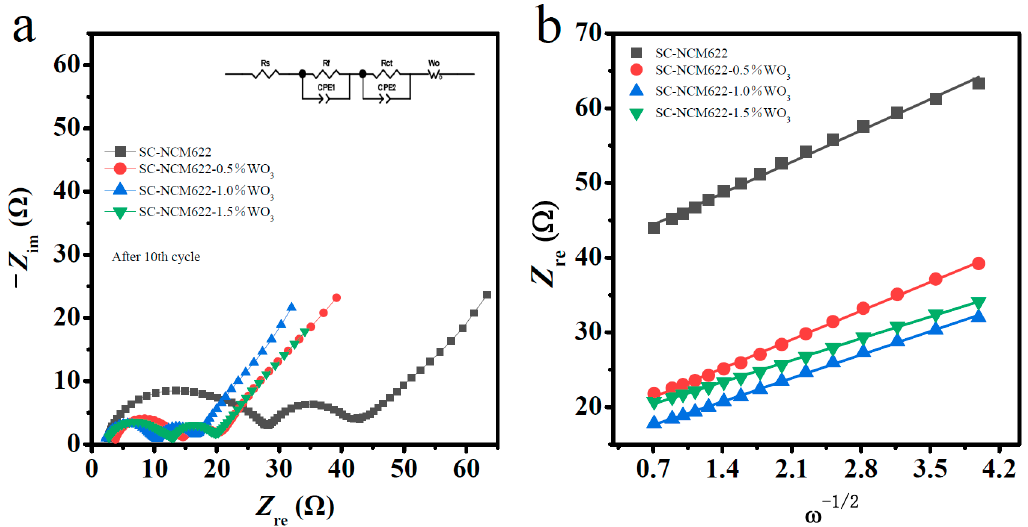
Figure 7. ( a ) Nyquist plots at charge state of 4.4 V after 10th cycle; ( b ) the relationships between Z re and ω − 1/2 for SC-NCM622, SC-NCM622-0.5%WO 3 , SC-NCM622-1.0%WO 3 and SC-NCM622- 1.5%WO 3 Table 2. The kinetic parameters of SC-NCM622, SC-NCM622-0.5%WO 3 , SC-NCM622-1.0%WO 3 and SC-NCM622-1.5%WO 3 .